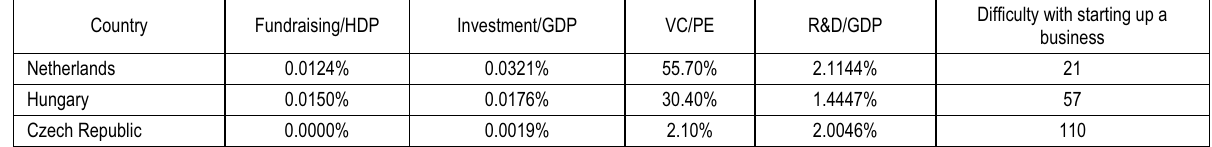
Table 2. Values, activities with venture capital in selected